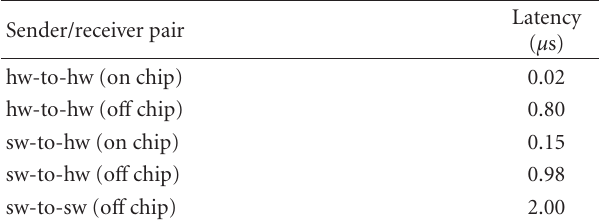
Table 3: Hardware send/receive latency through one hop.